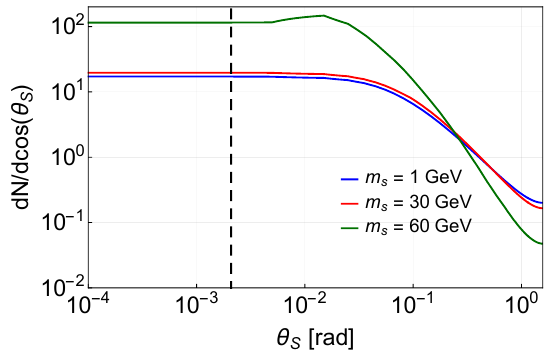
Figure 4 . The angular distribution of scalars for di(cid:11)erent scalar masses. The distribution is symmetric with respect to (cid:25)= 2 (right vertical axis). The vertical dashed line corresponds to (cid:18) S = (cid:18) faser 2 . The estimate is made under the assumption that Higgs bosons (cid:13)y along the beam axis (see text for details).